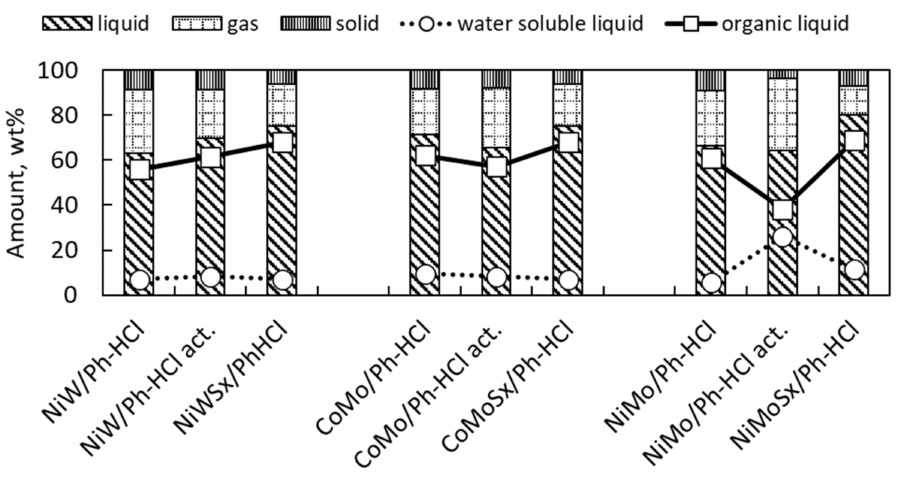
Figure 10. Gas-solid-liquid mass balance for all the catalytic tests.